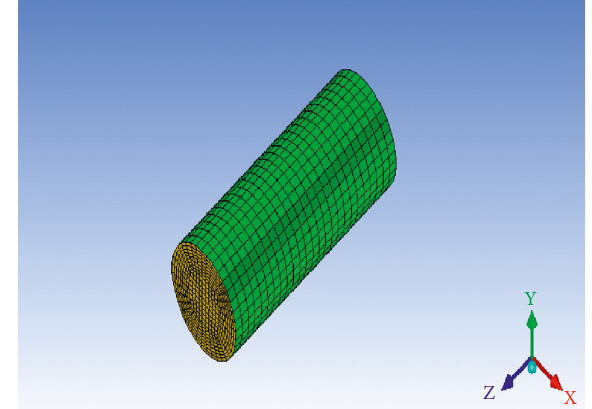
Figure 3: Model grid generation.